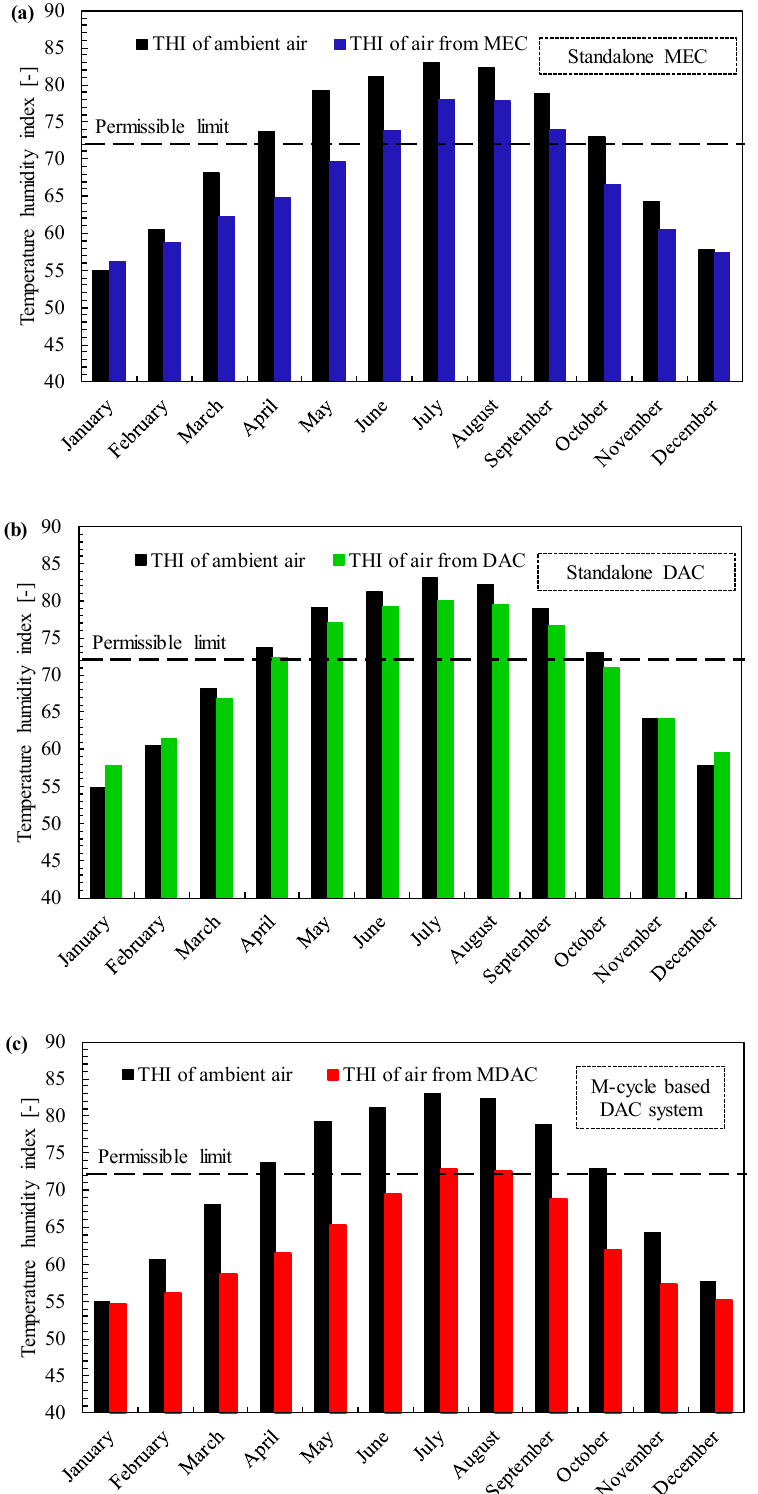
Figure 8. Analysis of proposed AC system options on monthly basis THI for Multan (Pakistan); ( a ) Stand-alone MEC system; ( b ) Stand-alone desiccant AC system; and ( c ) M-cycle based desiccant AC